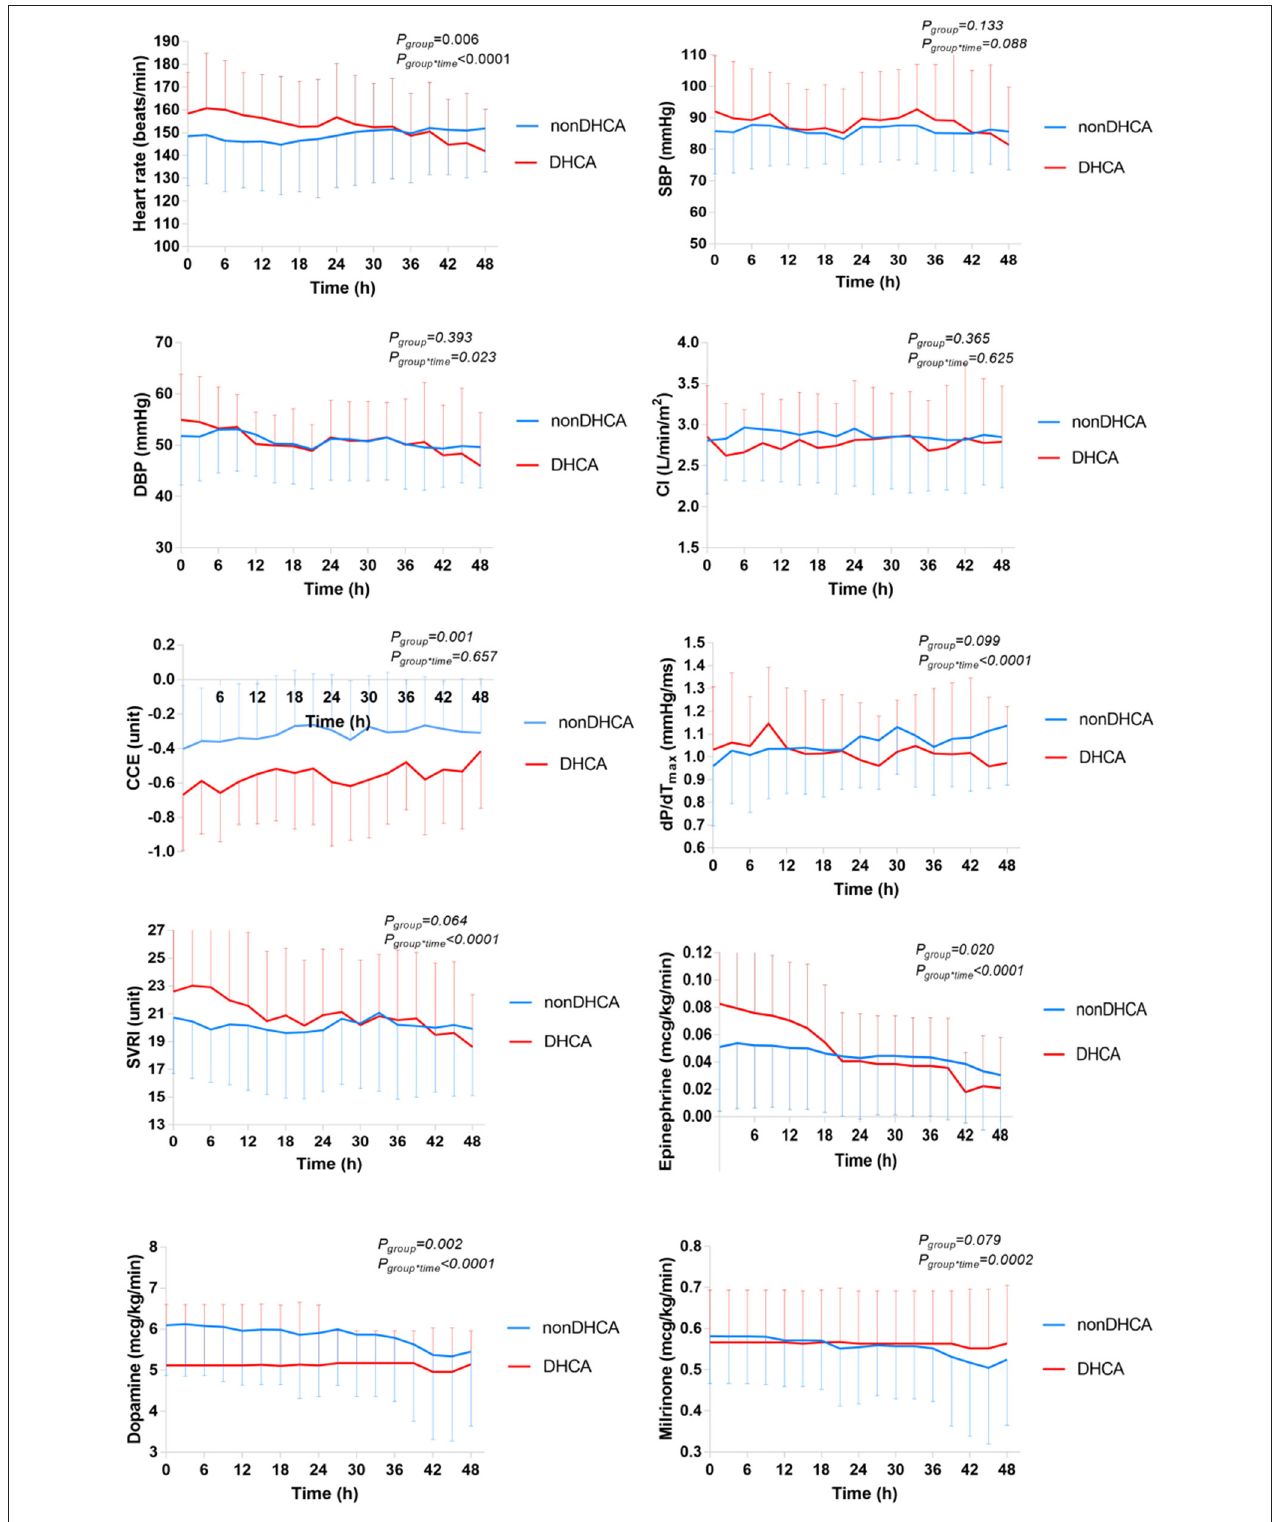
FIGURE 2 | Comparison of the temporal trends of the systemic hemodynamic and myocardial status between DHCA ( n = 17) and non-DHCA groups ( n = 74) during the first 48h after CPB. The mean value is presented, and the error bar represents the standard deviation. CCE, cardiac cycle efficiency; CI, cardiac index; DBP, diastolic blood pressure; dP/dT max , the maximal slope of systolic upstroke; SBP, systolic blood pressure; SVRI, systematic vascular resistance.